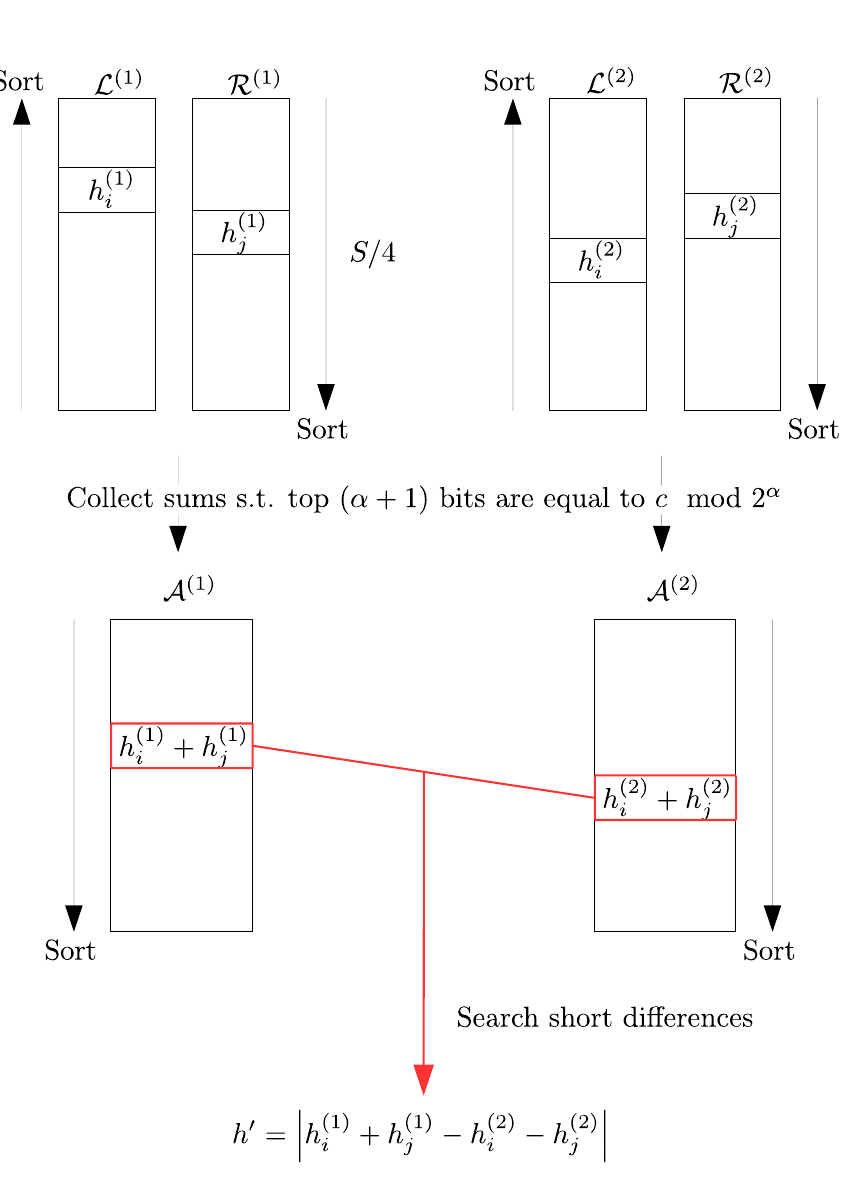
Figure 7: Overview of the Schroeppel–Shamir-based range reduction algorithm transformed from Howgrave-Graham–Joux’s